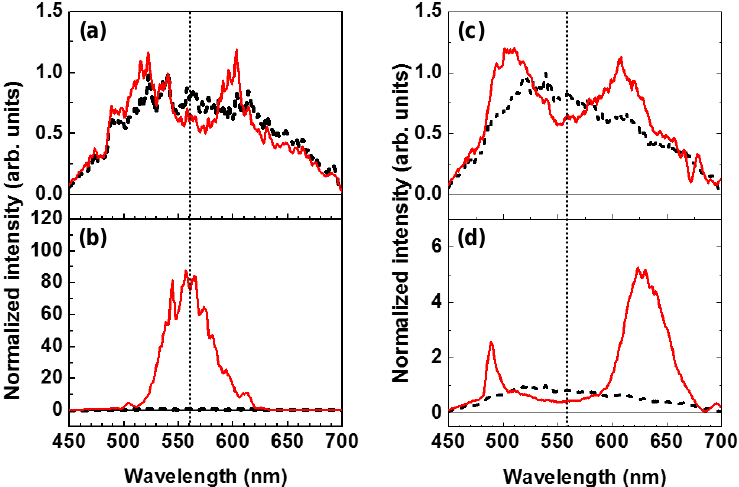
Figure 3. Spectra of output signal pulses from ( a , b ) the argon-filled hollow fiber and ( c , d ) air-filled hollow fiber. Solid lines and broken lines are the spectra obtained with and without use of the pump pulse, respectively. The energy of the pump pulse was 150  J for ( a ) and ( c ), while 470  J and 310  J for ( b ) and ( d ), respectively. All the spectra are normalized to the peak intensity of the output signal spectrum obtained without use of the pump